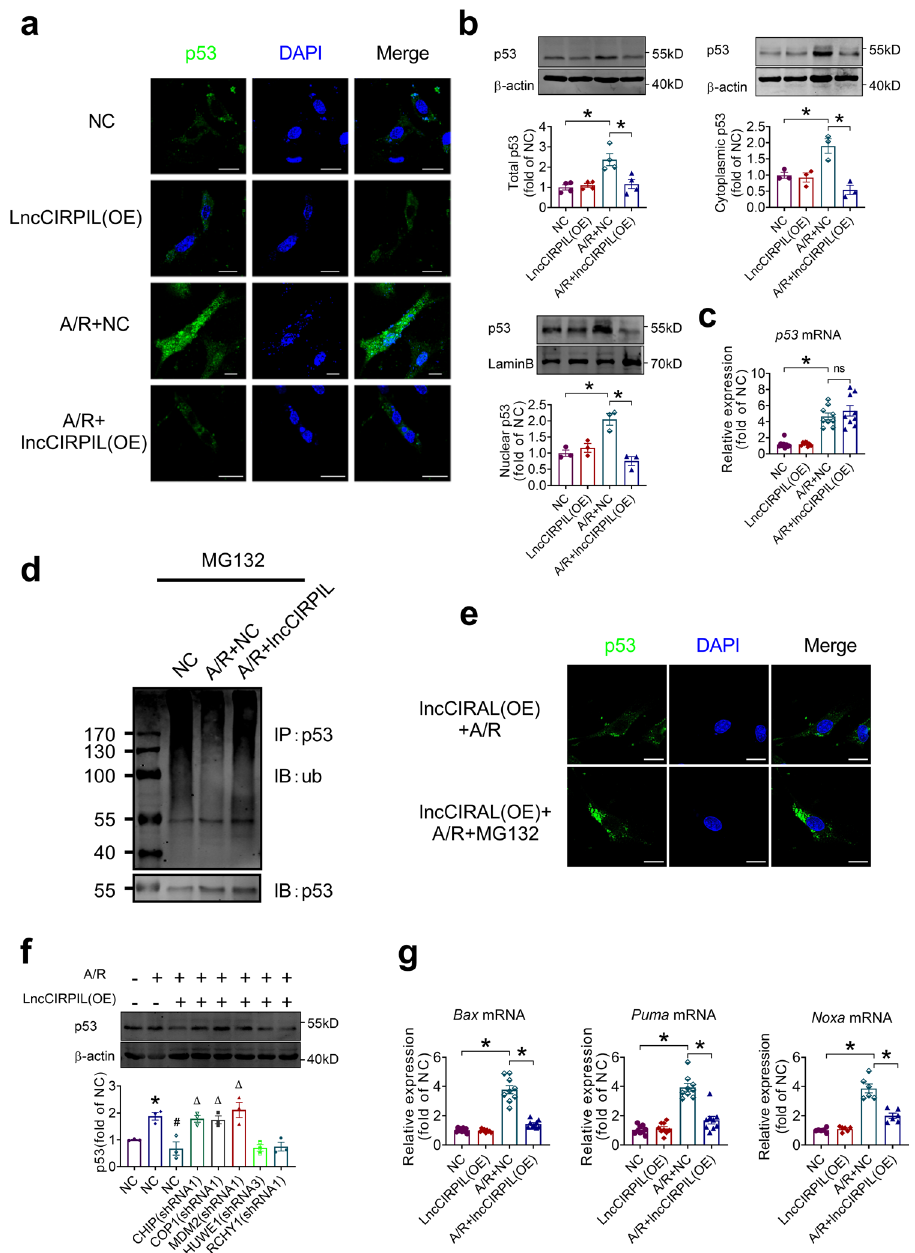
Fig. 6 LncCIRPIL promotes the ubiquitin-mediated degradation of p53 during cardiac injury. a In fl uence of lncCIRPIL overexpression on cytoplasmic and nuclear distribution of p53 in NMCMs subjected to A/R insult by immuno fl uorescence staining. n = 3. Scale bar = 20 μ m. b Effects of lncCIRPIL overexpression on total, cytoplasmic and nuclear levels of p53 in NMCMs subjected to anoxia/reoxygenation (A/R) insult. n = 3. * P < 0.05 by one-way ANOVA followed by Tukey post hoc analysis. c Effect of lncCIRPIL on the mRNA level of p53 in NMCMs subjected to A/R insult. n = 9 samples from 3 independent experiments. * P < 0.05 by one-way ANOVA, followed by Tukey post hoc analysis. d Effects of lncCIRPIL overexpression on the ubiquitination of p53 in NMCMs subjected to A/R insult. n = 4. e . Blocking of protein degradation by MG132 leads to cytoplasmic accumulation of p53 in lncCIRPIL overexpressing NMCMs subjected to A/R insult. n = 4. Scale bar = 20 μ m. f The shRNAs of CHIP, MDM2, COP1, HUWE1 and RCHY1 on the protein level